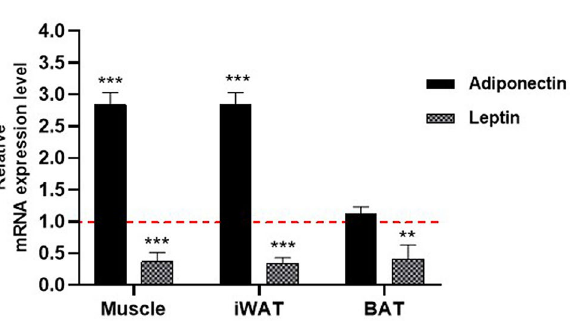
Figure 7. Effect of NAG-1 on the mRNA expression level of adipocytokines. Adiponectin and leptin mRNA expression levels in the muscle tissue, inguinal white adipose tissue, and brown adipose tissue were determined using quantitative real-time polymerase chain reaction. The expression levels of target genes were normalized with those of Gapdh . Data are presented as mean ± standard error and were analyzed using the Student’s t -test. *p < 0.05, **p < 0.01, and ***p < 0.001, compared with the control group (n =